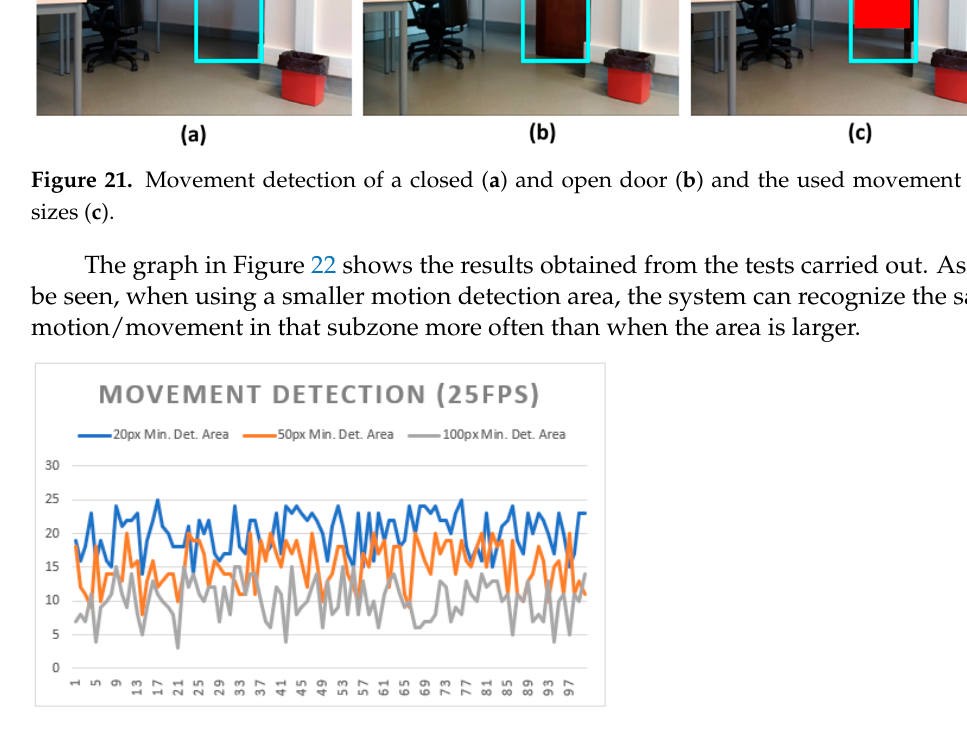
Figure 22. Movement detection with multiple minimum area sizes.